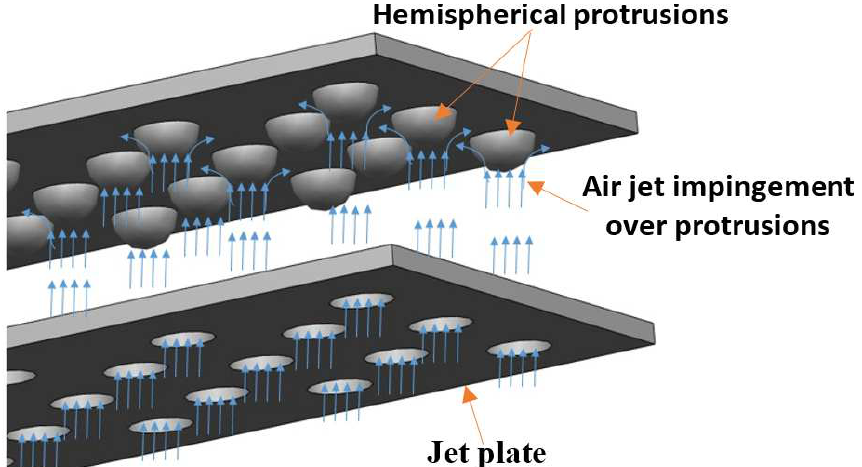
Figure 7. Air jet impinging flow pattern on protrusions.